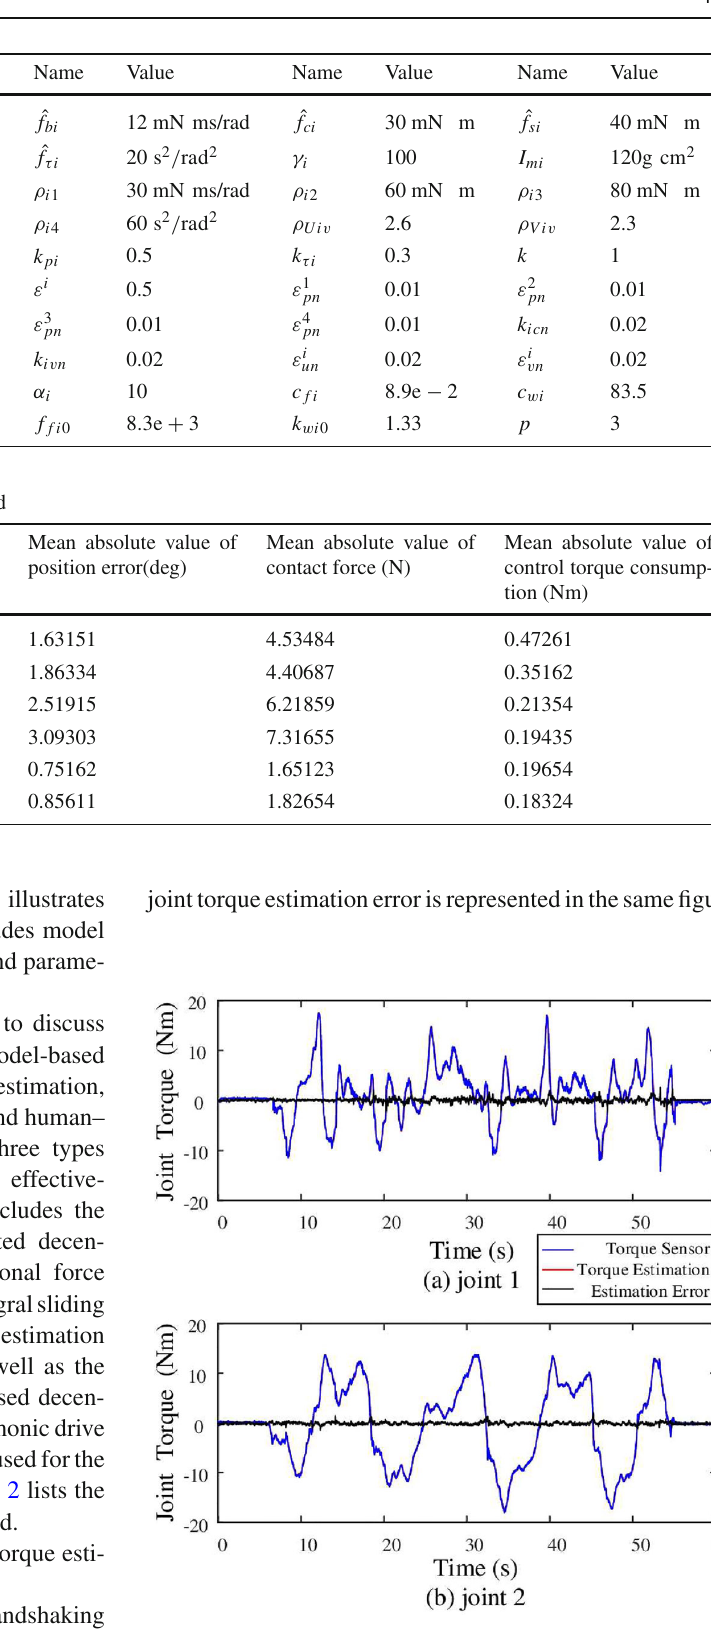
Fig. 5 Joint torque and torque estimation error curves under the pro- posed